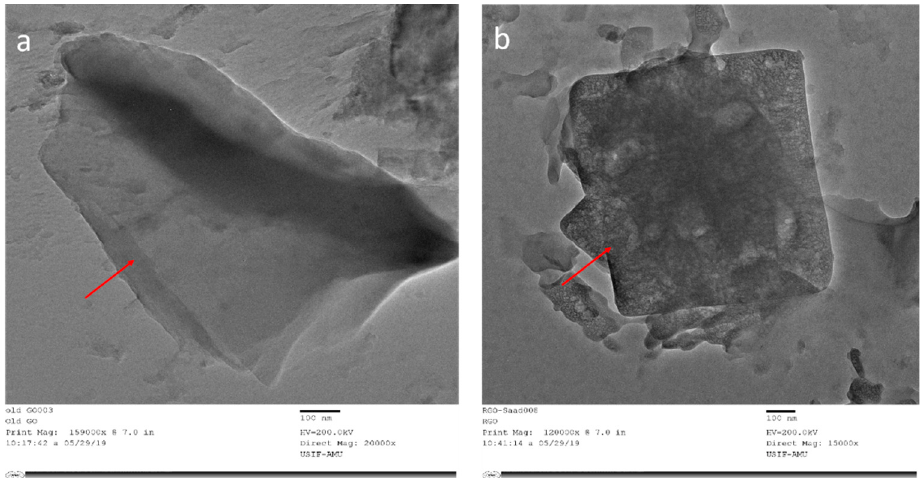
Figure 5. Transmission electron microscopy images of ( a ) GOX and ( b ) RGOX.